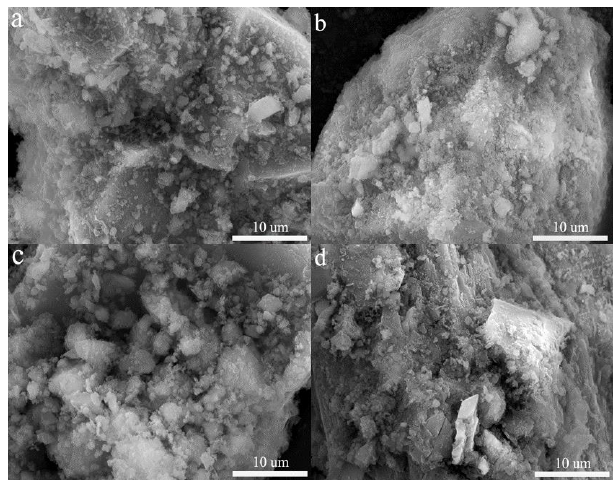
Figure 9. SEM images different pH and temperature: ( a ) pH = 1; ( b ) pH = 5; ( c ) temperature = 20 °C; ( d ) temperature = 60 °C.